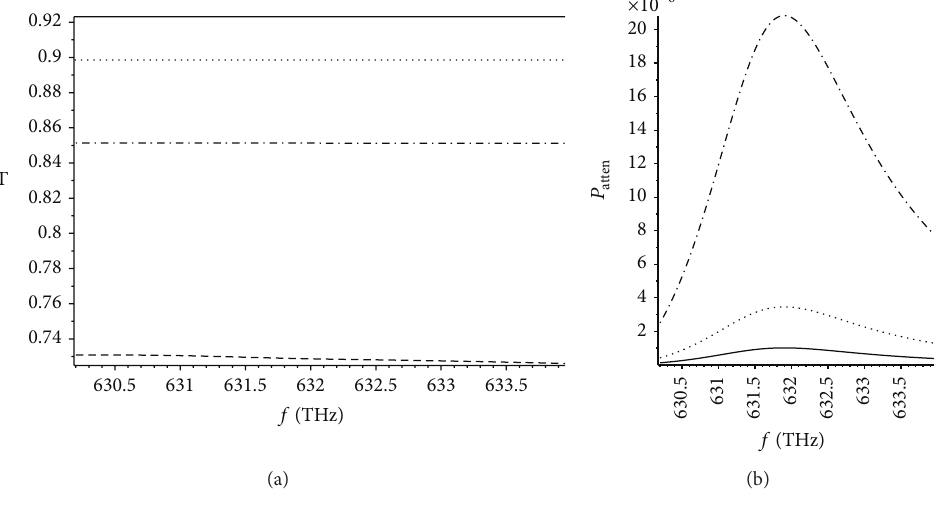
Figure 8: (a) The power confinement factor versus the operating frequency for mode orders 𝑚 = 0, 1, 2 , and 3 . (b) The power attenuation versus the operating frequency for modes orders 𝑚 = 1, 2 , and 3 . Note that 𝑚 = 0 (dash), 𝑚 = 1 (dot-dashed), 𝑚 = 2 (dotted), and 𝑚 = 3